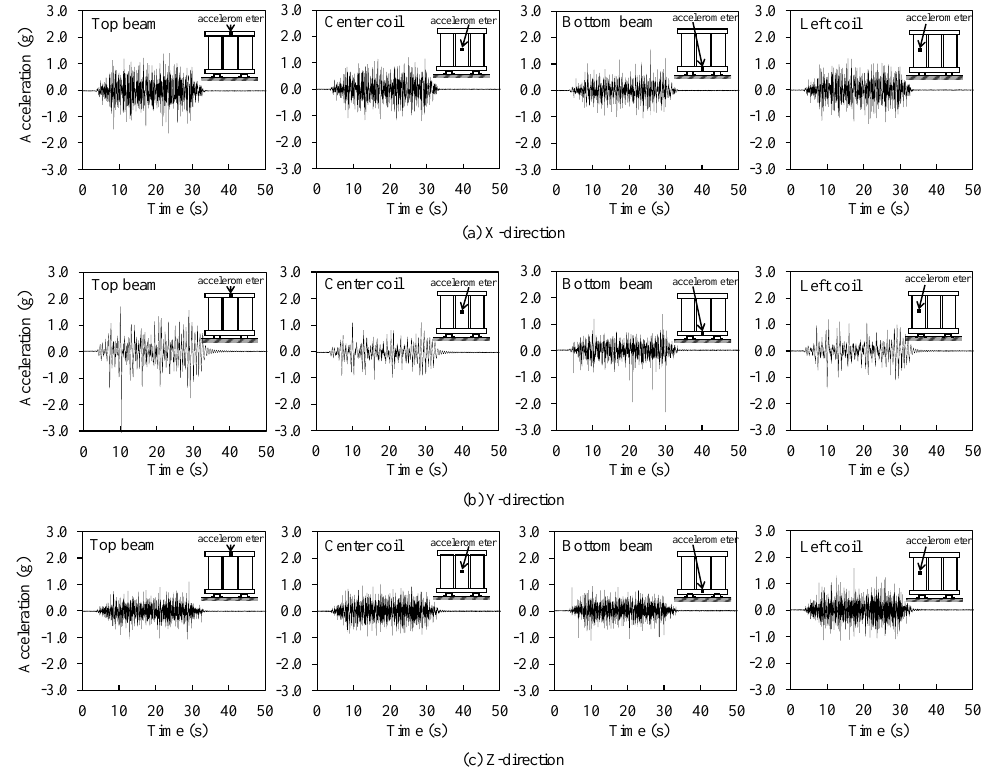
Figure 13. Acceleration response-time histories of test specimen of